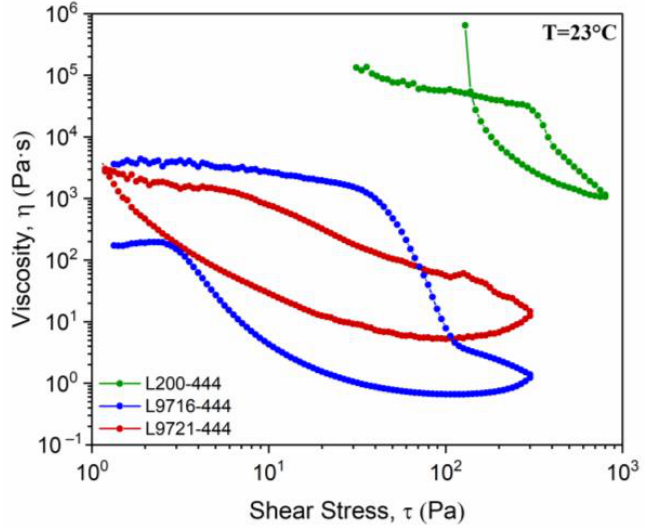
Figure 2. Flow characteristics of the pastes prepared by the binders with black pigment. In addition to the flow characteristics, the viscoelastic properties of the pastes were determined under non-destructive oscillatory conditions in the linear viscoelastic range, which was previously determined with stress sweep tests at a constant frequency of 1 Hz. Similarly to what was determined with the flow tests, the frequency tests (Figure 3) showed that the highest consistency, i.e., the values of dynamic moduli (elastic G (cid:48) and viscous G (cid:48)(cid:48) contribution to viscoelastic behavior) was observed for the paste with the L200 binder.